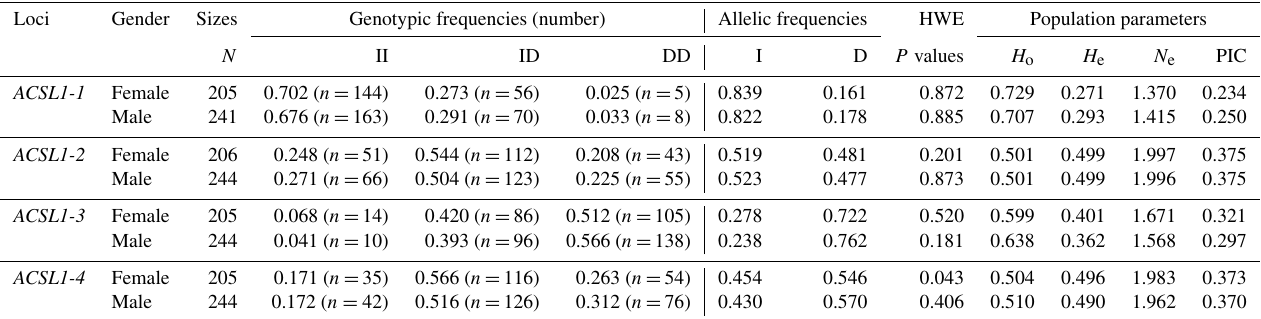
Figure 3. Detection of four mutation sites of the ACSL1 gene in Dezhou donkeys by PCR. II: insertion/insertion; ID: insertion/deletion; DD: deletion/deletion; and M: marker2000. Table 2. Detection of genotype frequencies, allele frequencies and population genetic parameters of ACSL1 gene mutation loci in Dezhou donkeys of different